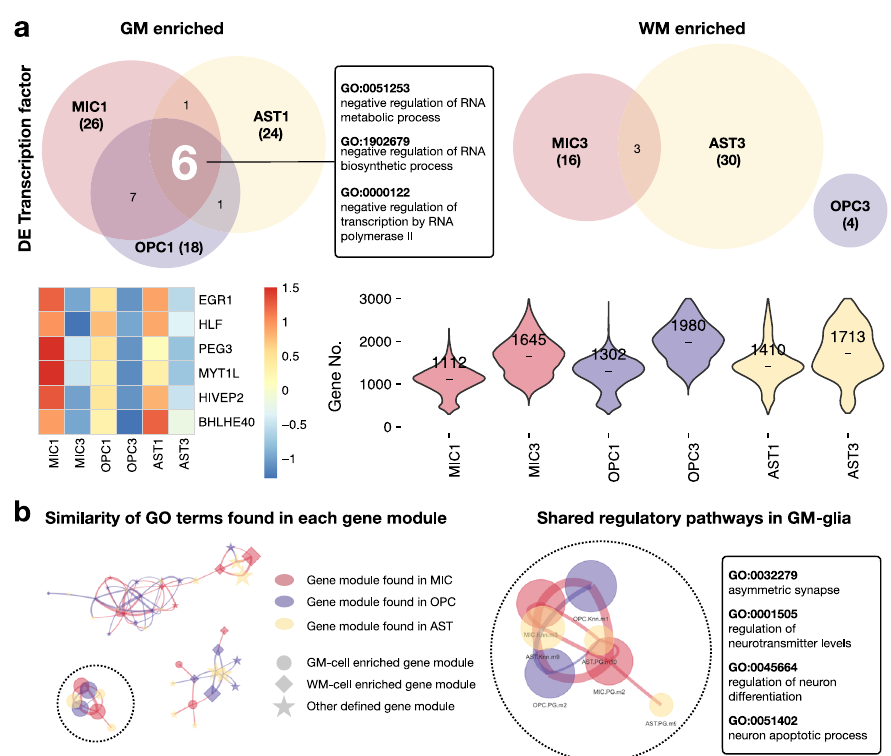
Fig. 7 | GM-glia share regulatory pathways and express fewer genes than WM- glia. a Venn diagram showing shared, differentially expressed transcription factors across GM-glia (left) and WM-glia (right). GO processes of the six shared transcription factors in GM-glia. Heatmap showing expression of the six shared transcriptionfactors.Violinplotshowingthenumberofdifferentiallyexpressed genes detected in each cluster, with median annotated. DE differentially